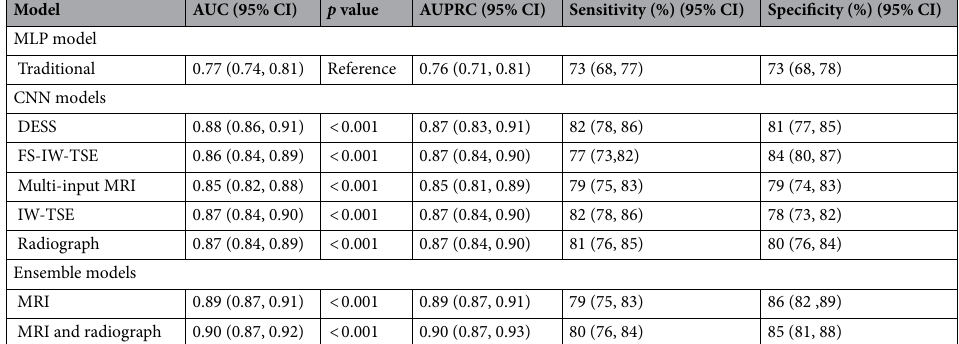
Table 1. Receiver operator characteristic analysis with areas under the curve (AUC) and area under the precision-recall curve (AUPRC) evaluating the diagnostic performance of the models to predict total knee replacement (TKR) using sevenfold nested cross-validation on the training a validation group in the OAI database. MLP Multi-layer perceptron, 3D Three-dimensional, CNN Convolutional neural network, CI Confidence interval, DESS Sagittal fat-suppressed three-dimensional dual-echo in steady state, FS-IW-TSE Sagittal fat-suppressed intermediate-weighted turbo spin-echo, IW-TSE Coronal intermediate-weighted turbo